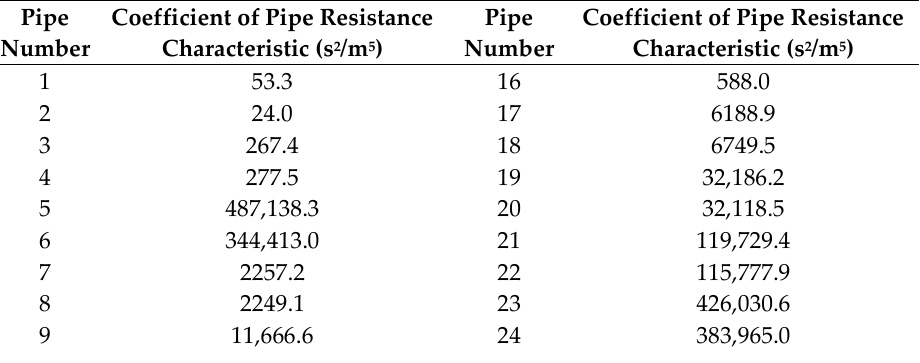
Table 4. Results of identification of the case pipe network’s characteristics.